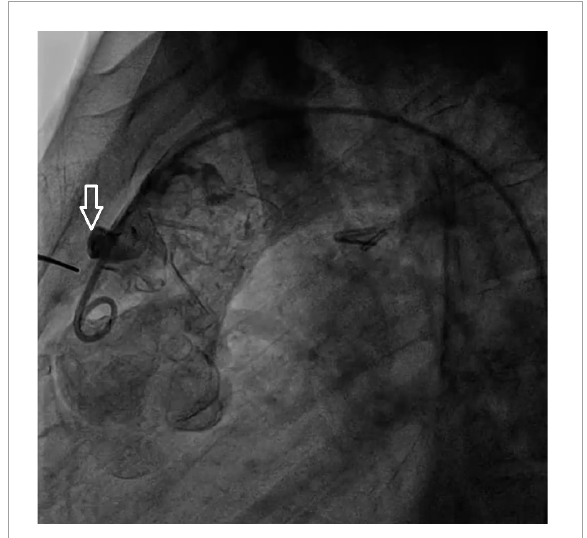
FIGURE3 Angiographic view of the occluded shunt (arrow) before intervention.